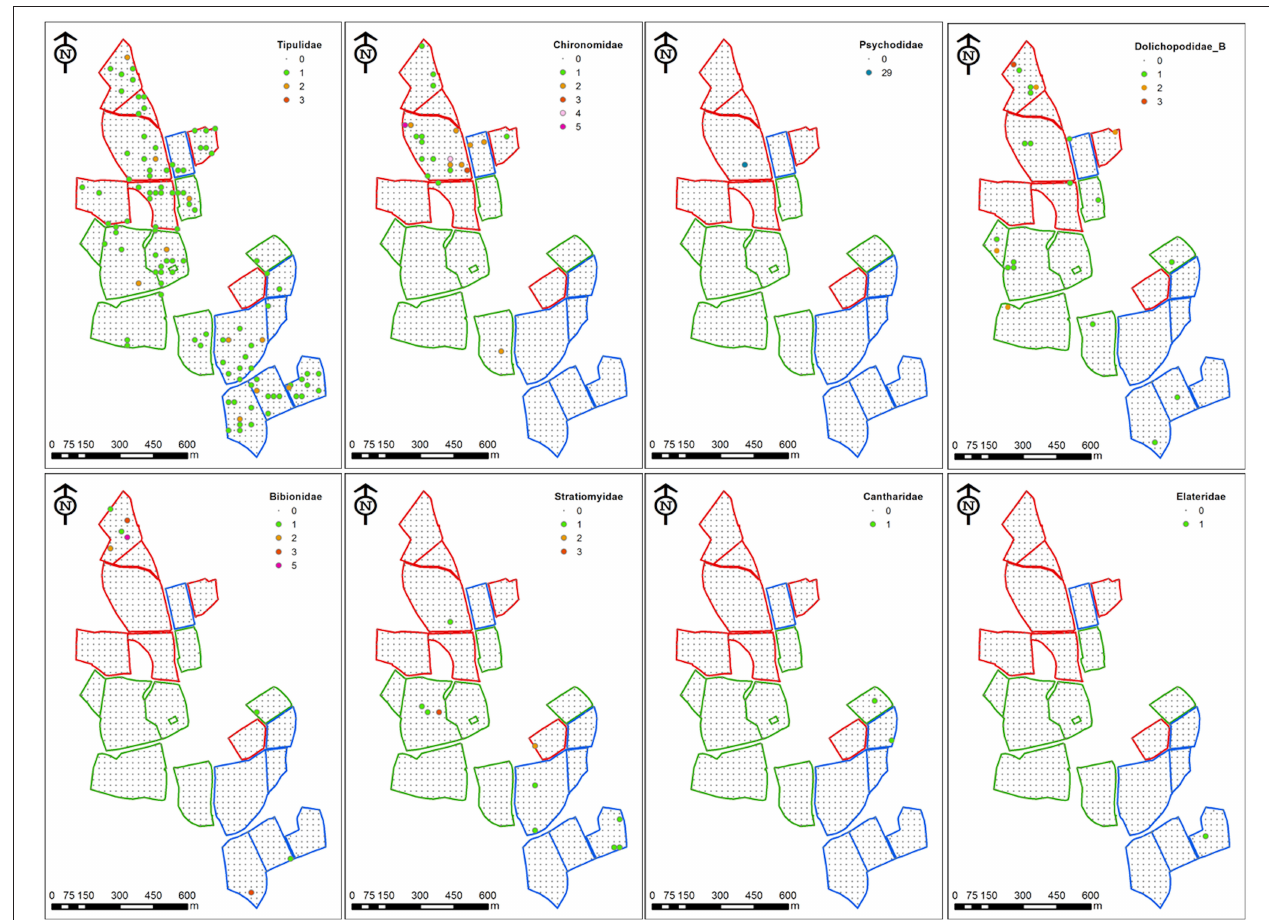
FIGURE 2 | Distribution maps of selected taxa on the North Wyke Farm Platform in 2013. Individual soil cores were taken (1130 in total) across 19 fields in three farms (red boundaries = Farm 1, green = Farm 2 and blue = Farm 3). Large circles represent sampling points containing individuals, colored by abundance (see individual